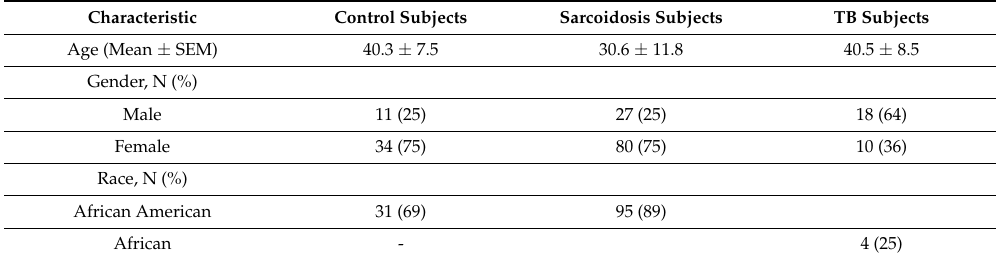
Table 1. Subjects